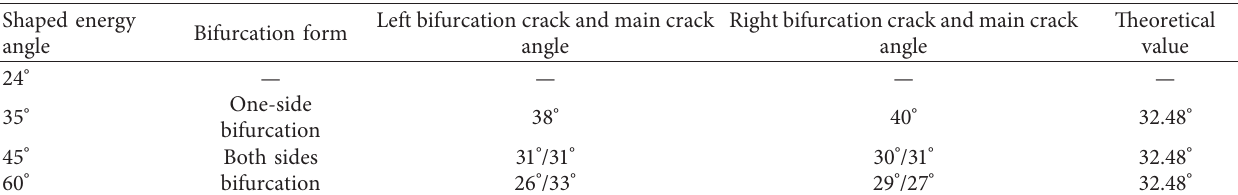
Figure 14: Schematic diagram of 60 ° shaped energy blasting crack. (a) Crack angle versus crack length for 60 ° shaped energy angle. (b) Time evaluation of crack angle for 60 ° shaped energy angle. (c) Time evaluation of crack length for 60 ° shaped energy angle. Table 4: Statistics of crack bifurcation